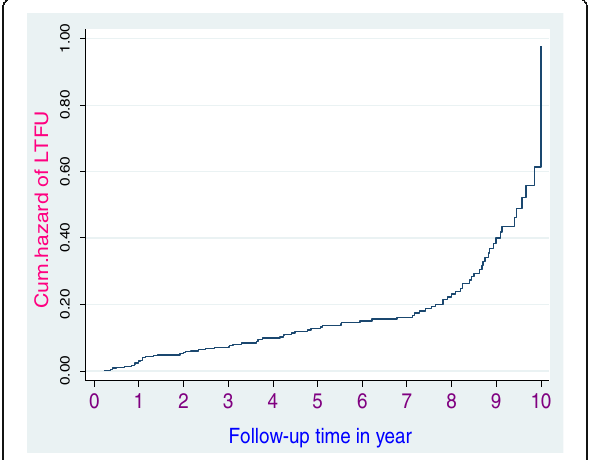
Fig. 1 The cumulative hazard rate of lost to ART follow-up among HIV-positive adult individuals at Debre Markos Referral Hospital, North-West Ethiopia, from January 30, 2008, to January 26,